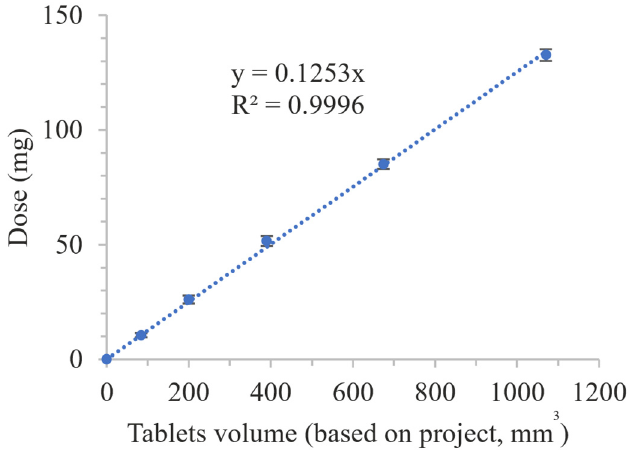
Figure 13. Volume–dose